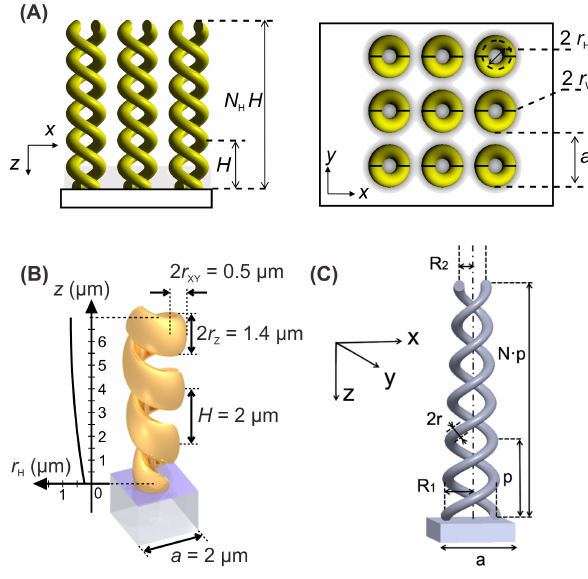
Figure 2: (A) Illustration of the optimized double-helix design (reprinted with permission from [24]. Copyright 2012 OSA). (B) Illus- tration of a tapered helical design that increases both, bandwidth and extinction ratio (adapted with permission from [26]. Copyright 2012 AIP Publishing LLC). (C) Combining the ideas of (B) and (C) yields a tapered double-helix design (reprinted with permission from [27]. Copyright 2012